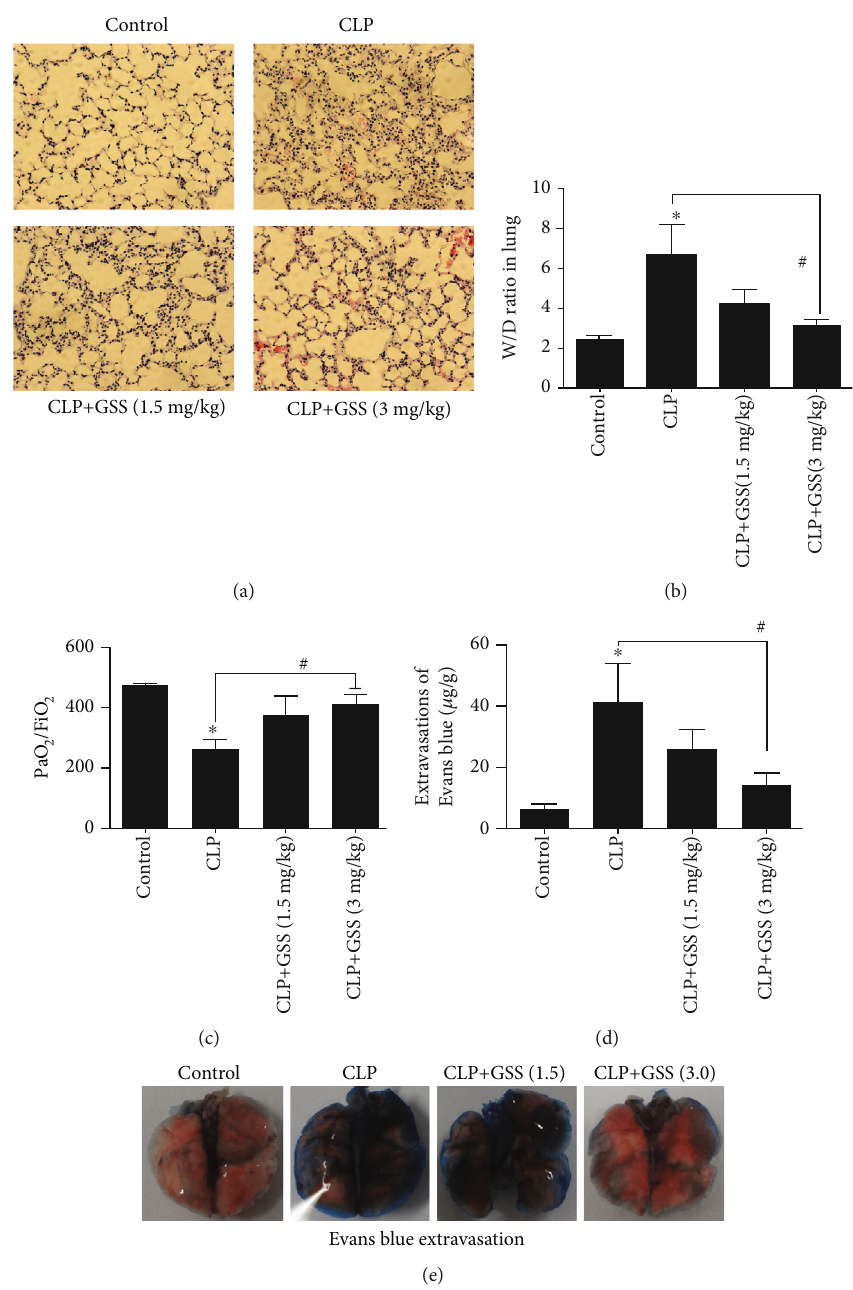
Figure 1: GSS inhibits sepsis-induced acute lung injury and vascular barrier dysfunction in mice. The mouse lungs harvested 24h after CLP application. (a) Sepsis in C57BL/6J mice was induced by the CLP procedure after pretreatment of GSS, and the histological analysis of lung tissue was analyzed by hematoxylin and eosin staining. (b) Wet/dry ratio of lungs was represented as a histogram according to data. (c) The PaO /FiO ratio was detected after CLP in mice with and without GSS treatment. (d) The quantitative analysis of Evans blue extravasation was 2 2 performed by spectrophotometric analysis of Evans blue extracted from the lung tissue samples. (e) Evans blue dye was injected 2 hours before termination of the experiment. ∗ P < 0 : 05 versus negative control. # P < 0 : 05 versus the corresponding CLP treatment